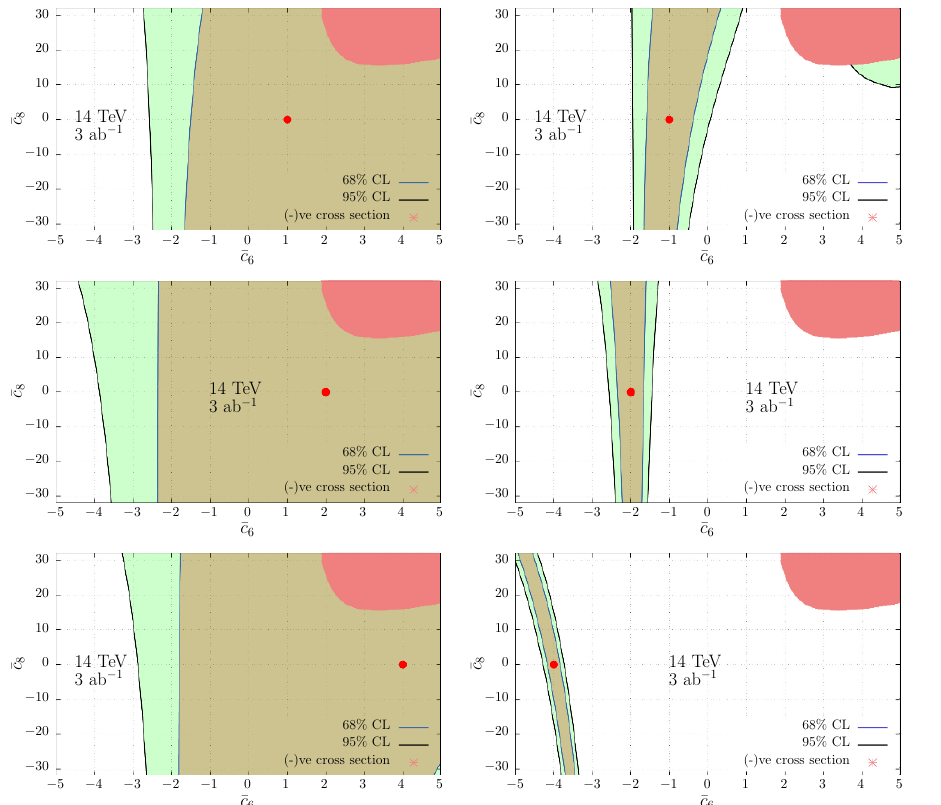
Figure 14 . Expected 1 (cid:27) and 2 (cid:27) bounds in the ((cid:22) c 6 ,(cid:22) c 8 ) plane at 14 TeV, assuming (cid:22) c true and (cid:22) c true = 0 (denoted by red 8